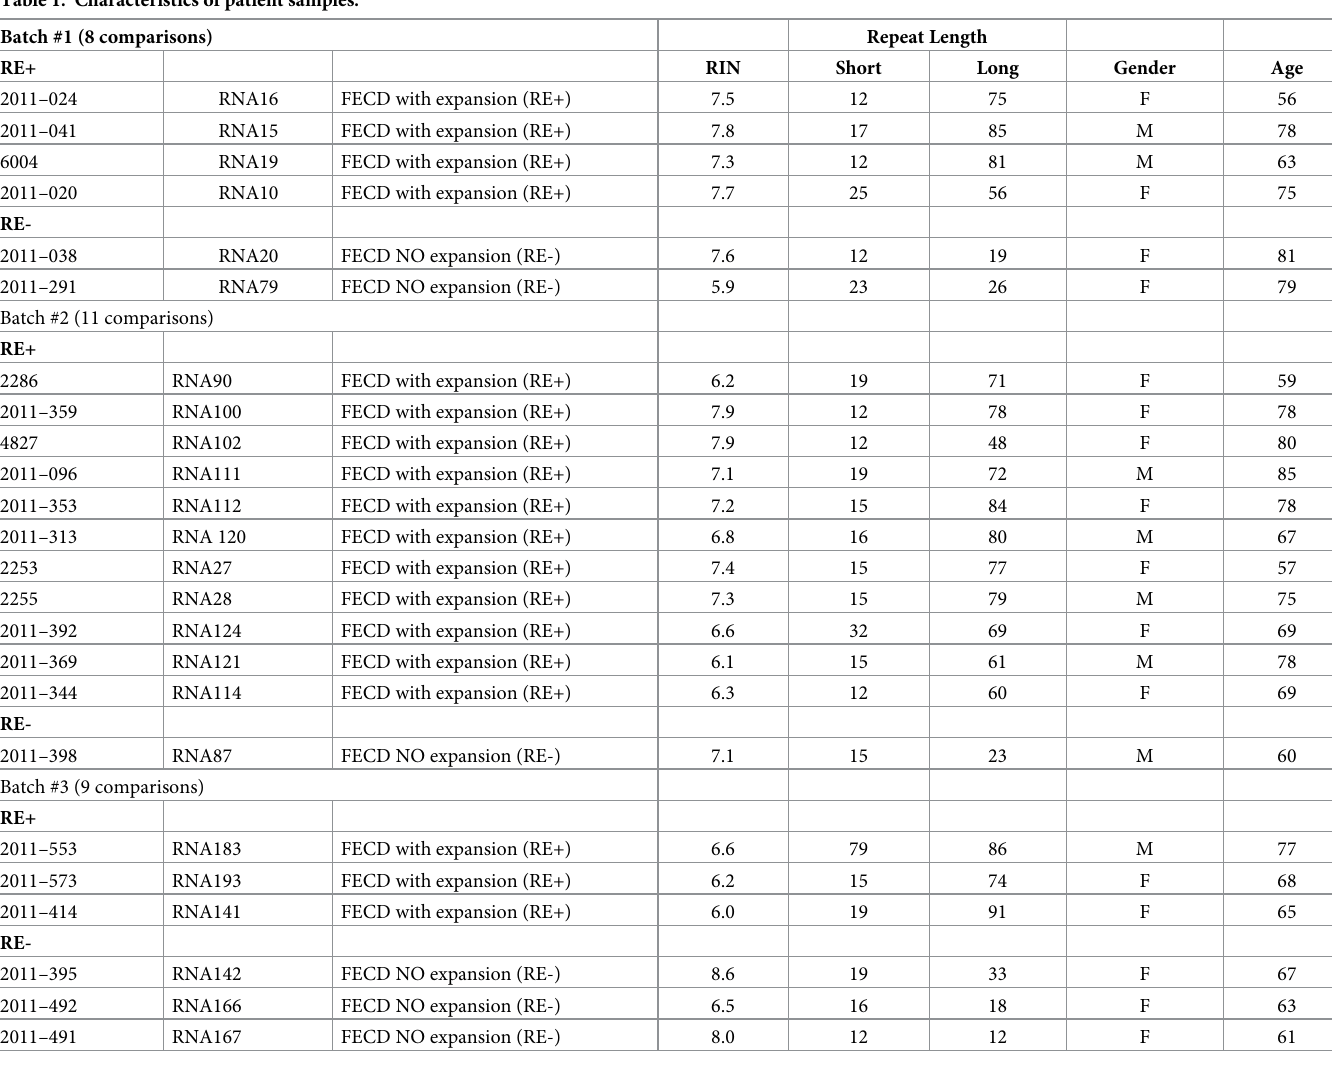
Table 1. Characteristics of patient